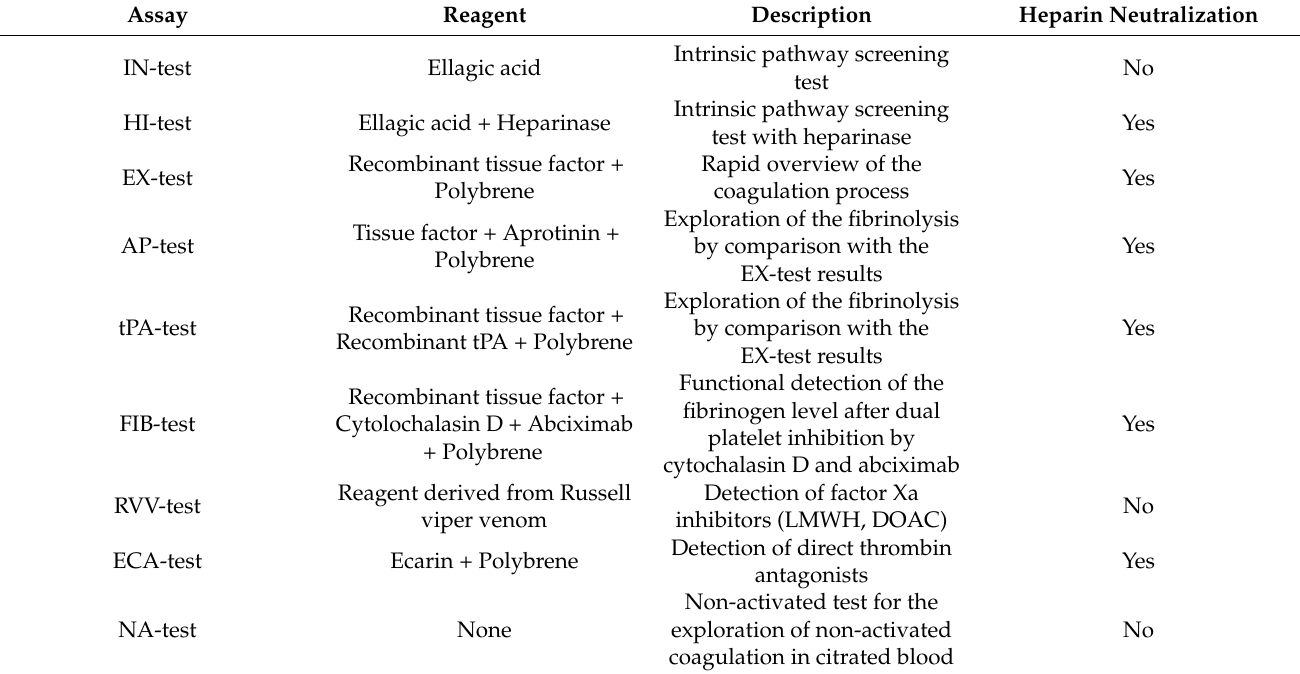
Table A7. ClotPro®reagents.